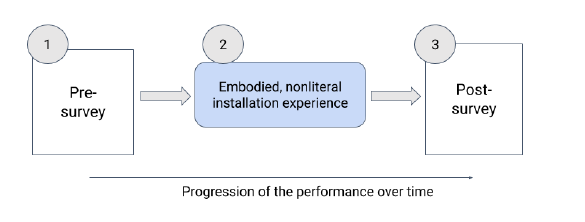
Figure 2: The experiment design illustrated from beginning to end. Two surveys were used to collect initial audience perceptions fol- lowed by their perceptions post participation in the installation. The surveys were completed in a separate, smaller area tangential to the installation, therefore delineating visual and environmental differences between the installation and the research collection